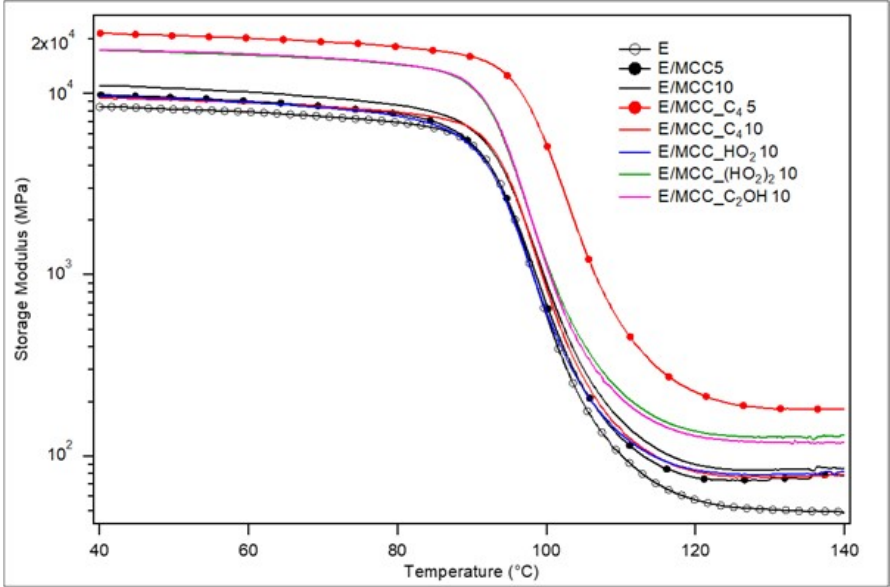
Figure 7. Storage modulus curves for epoxy and the MCC/epoxy composites. Table 6. Normalized storage moduli and effectiveness of fillers reinforcement (C) for the MCC/epoxy composites.